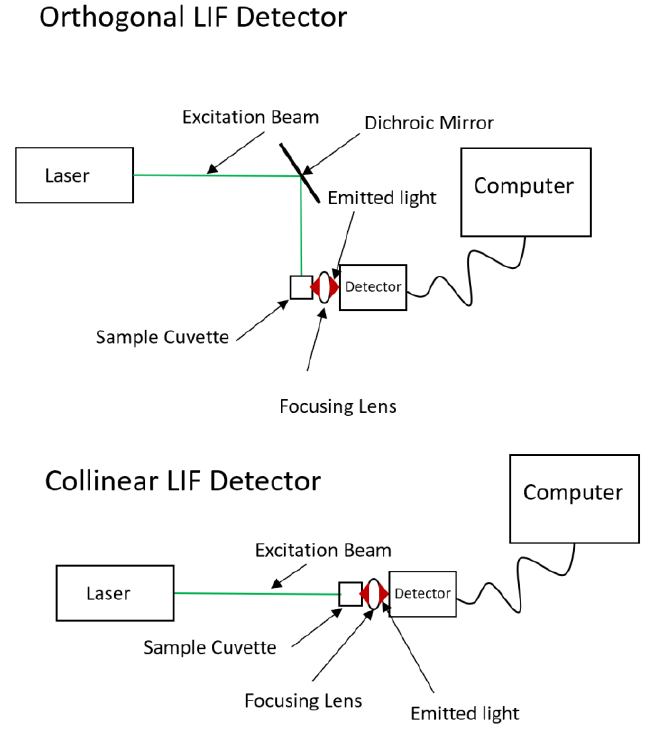
Figure 2. Simplified designs for orthogonal and collinear LIF detector arrangements.